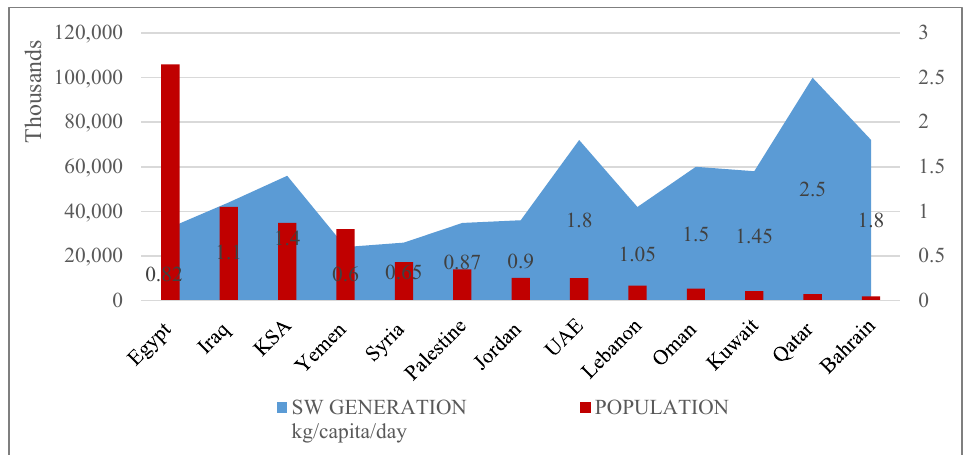
Figure 4. Population and waste generated in kg/capita/day for each Arab country.